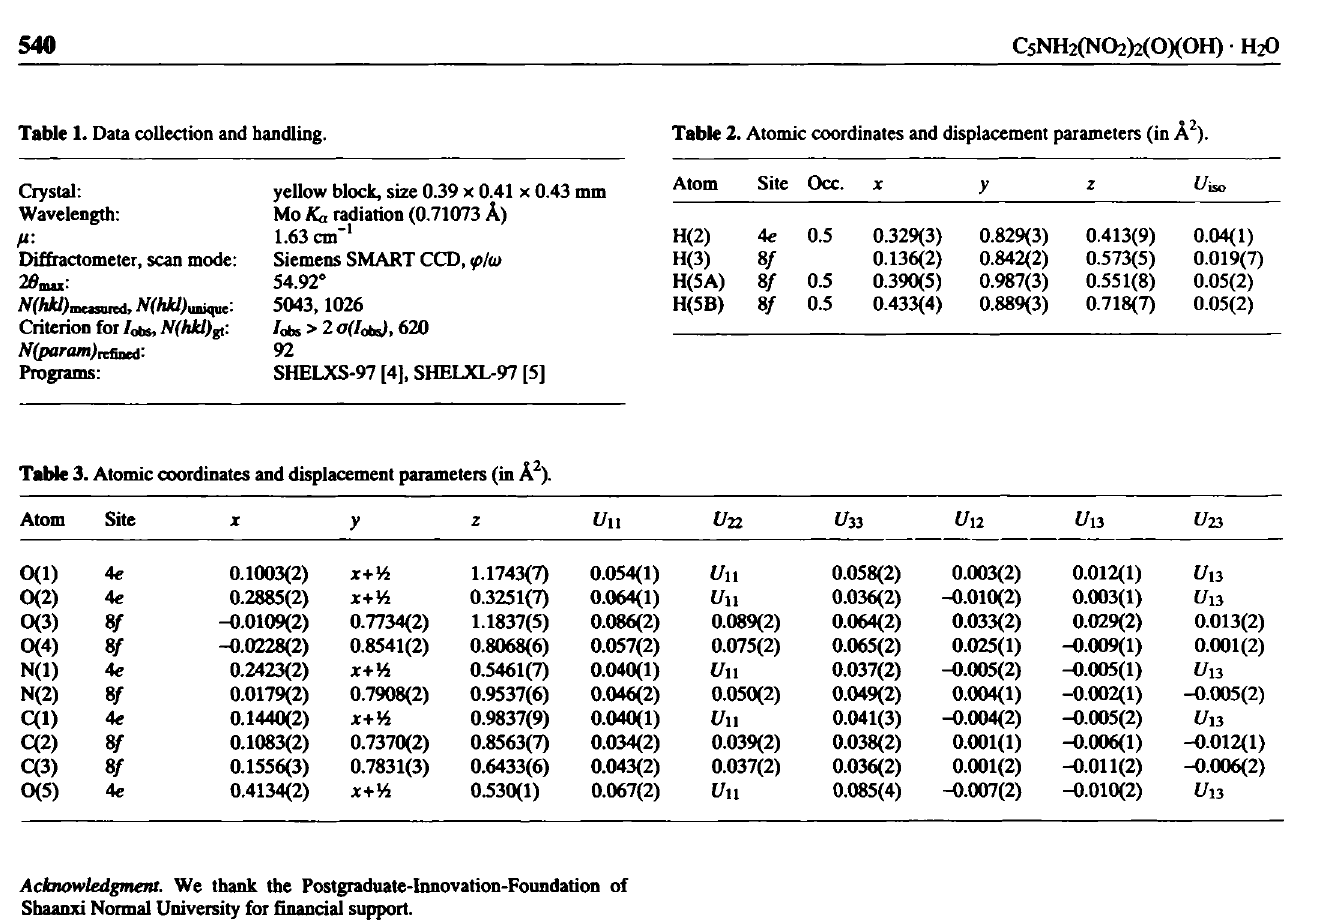
Table 1. Data collection and handling. Table 2. Atomic coordinates and displacement parameters (in Ä 2 ).